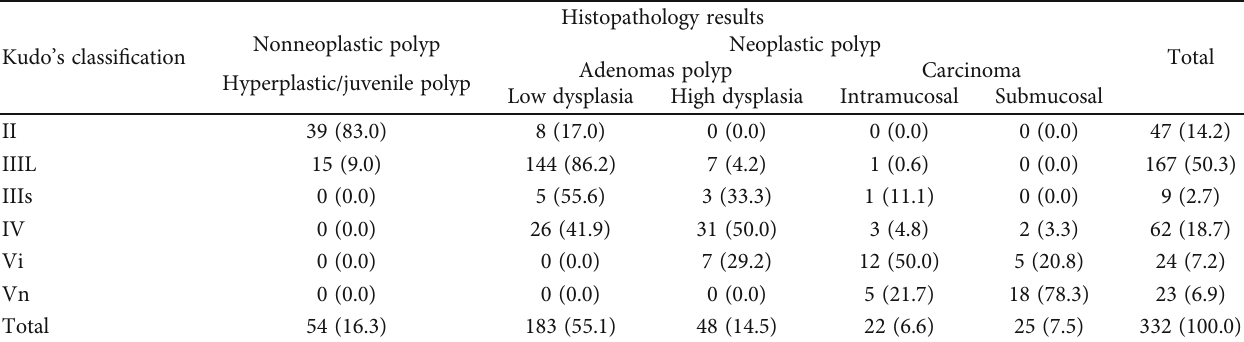
Table 4: Relationship between Kudo pit pattern classi fi cation of magnifying chromoendoscopy with Crystal violet and histopathology results ( n = 332